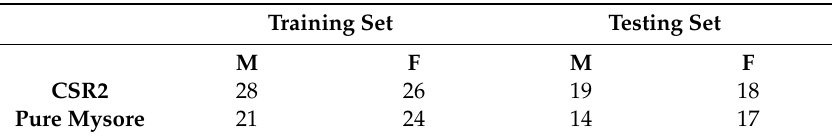
Table 3. Dataset for silkworm